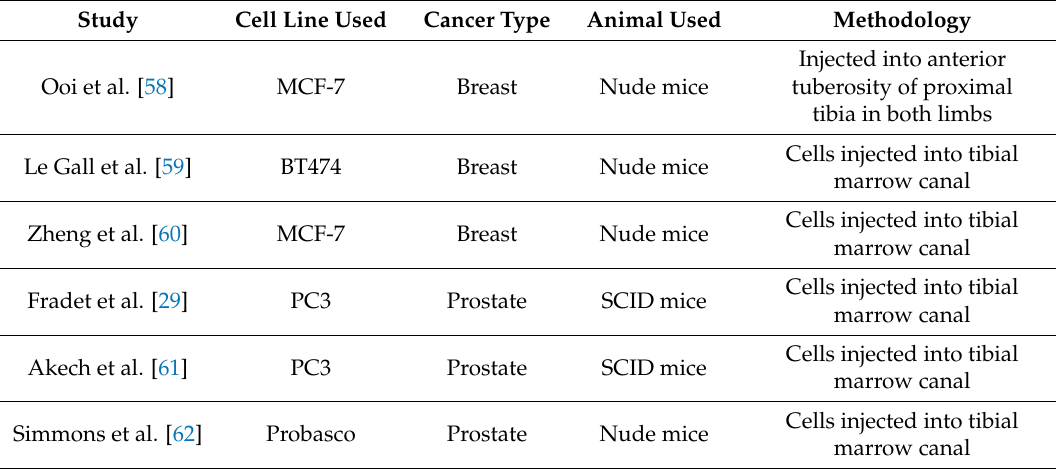
Table 1. Intraosseous